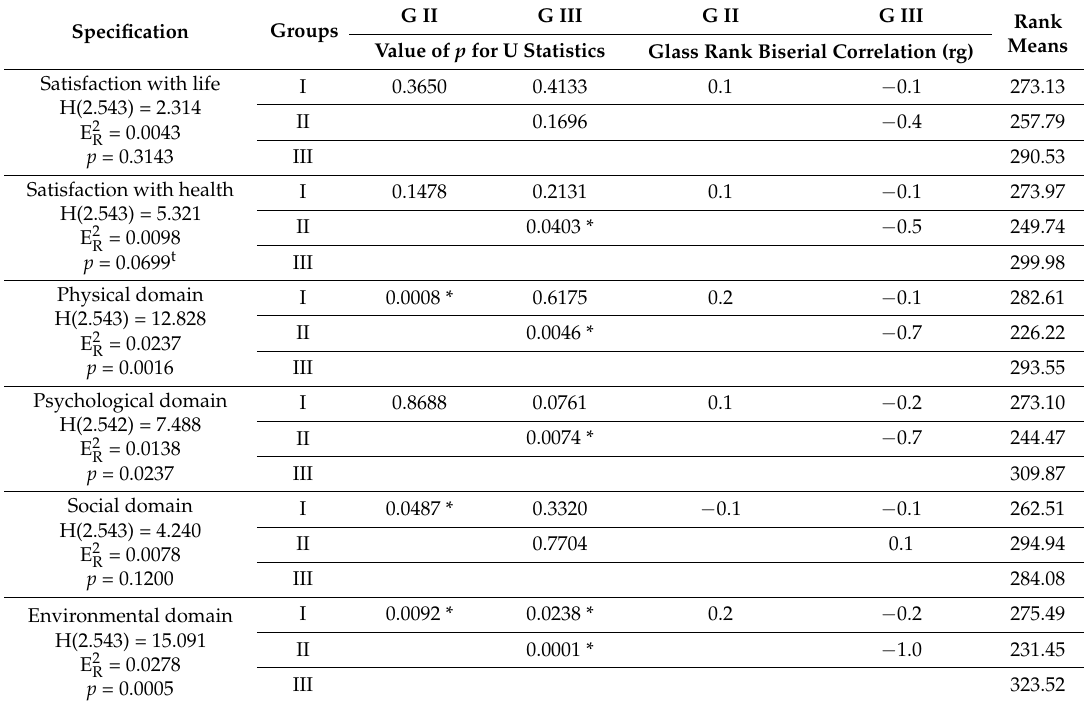
Table 3. Satisfaction with life, health and particular domains of the quality of life (WHOQOL-BREF) of , test U, rg). people who practice combat sports and martial arts (test H, E 2 R G II G III Specification Groups MeansValue of p for U Statistics Glass Rank Biserial Correlation (rg) Satisfaction with life H(2.543) =